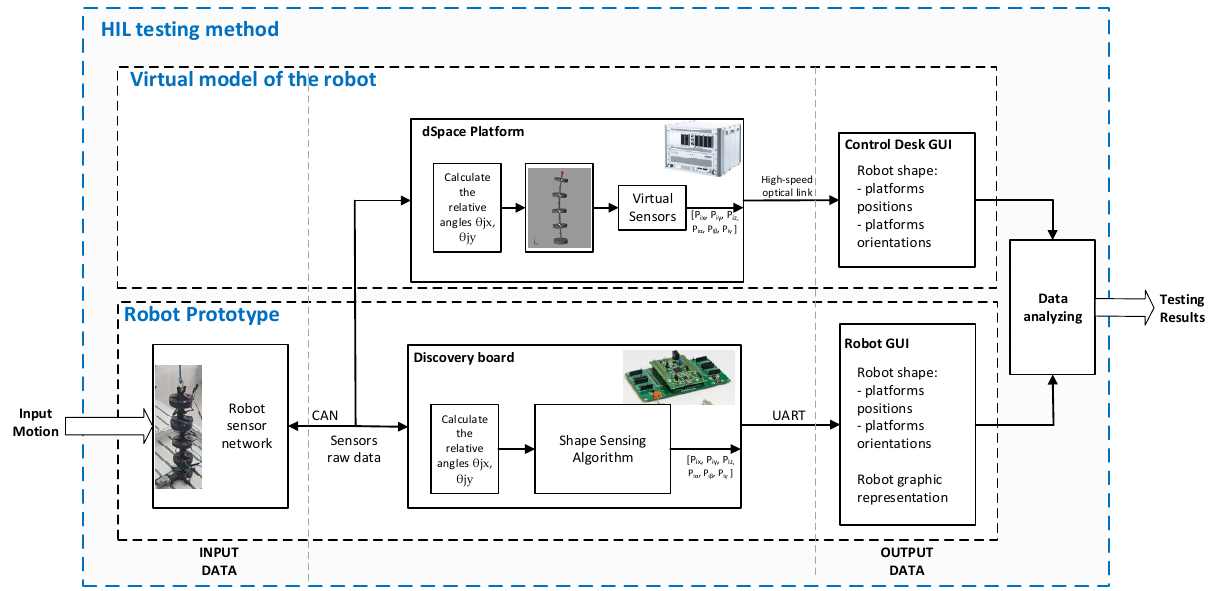
Figure 5. Conceptual diagram for the proposed testing method .